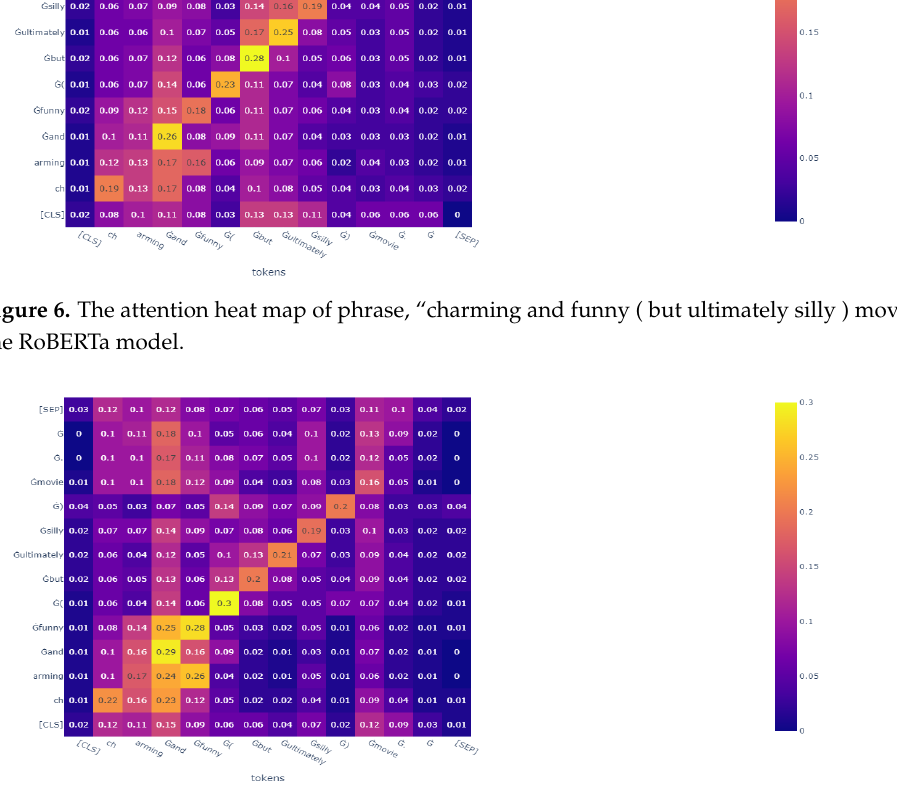
Figure 7. The attention heat map of phrase, “charming and funny ( but ultimately silly ) movie.”, in our FA-RoBERTa